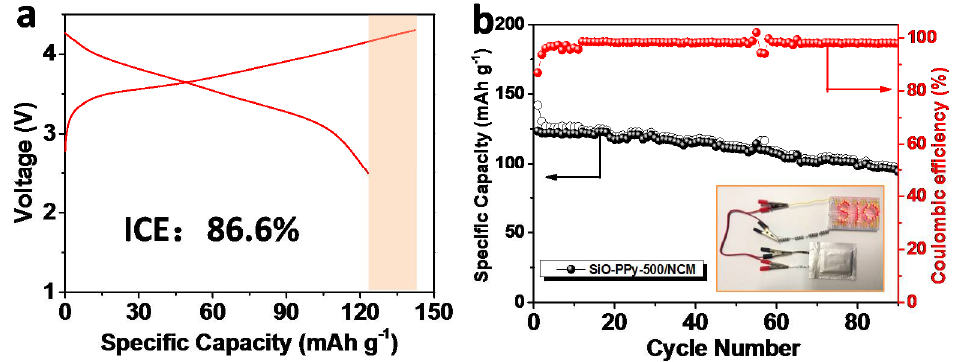
Figure 5. ( a ) Galvanostatic discharge/charge profiles of the prelithiated SiO-PPy-500|NCM full-cell in the first cycles at 1 C and ( b ) cycling performance for 90 cycles at 1 C. The inset shows an array of commercial red light-emitting diodes (LEDs) for SiO powered by the assembled full-cell.